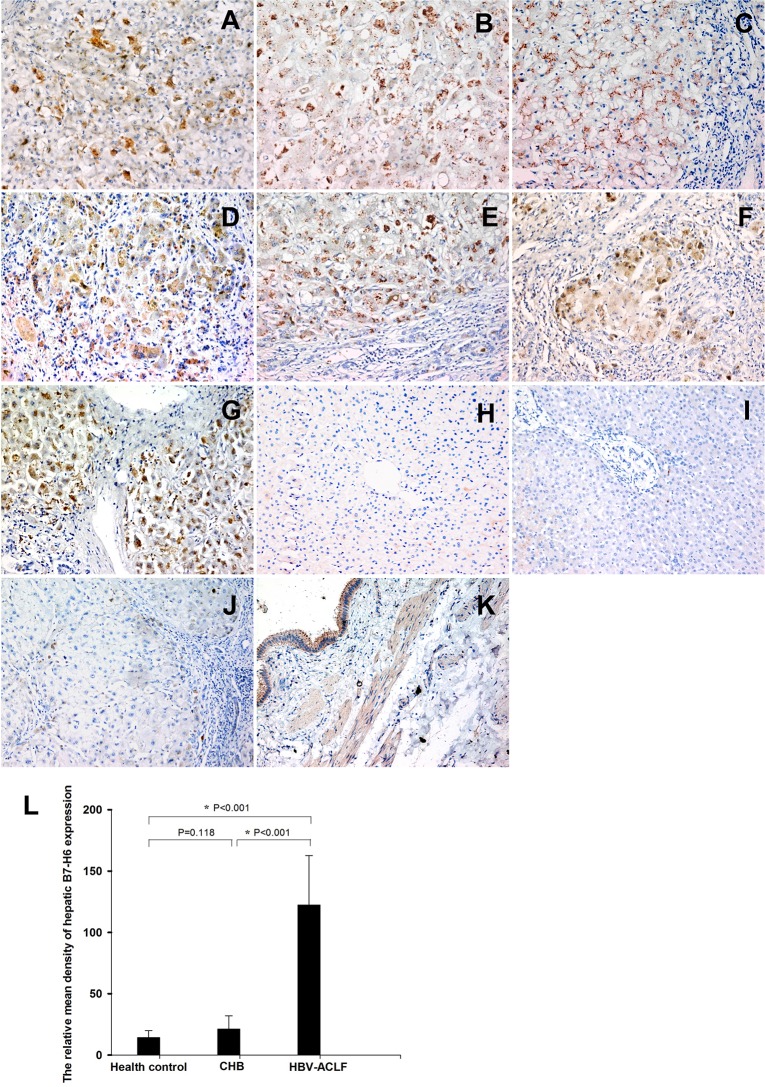
Enhanced expression of hepatic B7-H6 in HBV-ACLF patients.The detection of hepatic B7-H6 expression in patients with HBV-ACLF (Fig 1, A–G, original magnification 200x), mild CHB (Fig H, original magnification 200x), healthy controls (Fig 1I, original magnification 200x) was performed by immunohistochemical staining. B7-H6 staining with rabbit serum as first antibody was used as experimental negative controls (Fig 1J, original magnification 200x). According to the manufacturer's instructions, B7-H6 staining in human gallbladder tissue was used as the positive control (Fig 1K, original magnification 200x). Relative mean density analysis indicated that hepatic B7-H6 expression was significantly higher in HBV-ACLF patients than in mild CHB patients or in healthy controls (P < 0.05).